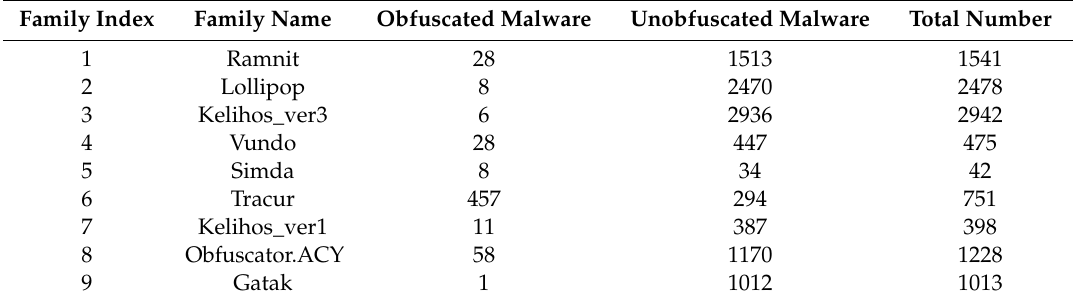
Table 1. Total number of obfuscated and unobfuscated malware, by family, used in the